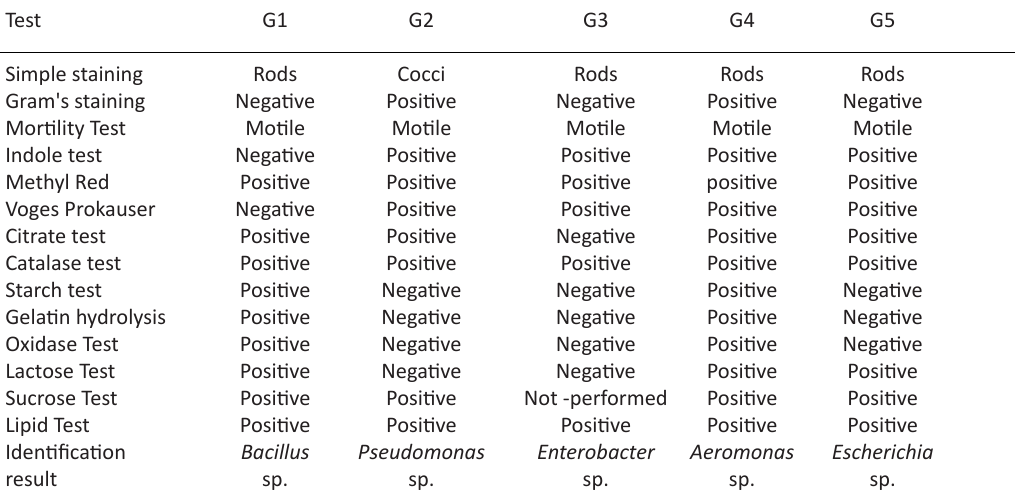
Table 3. Biochemical characterization of intestinal bacteria of Blue Gourami Test